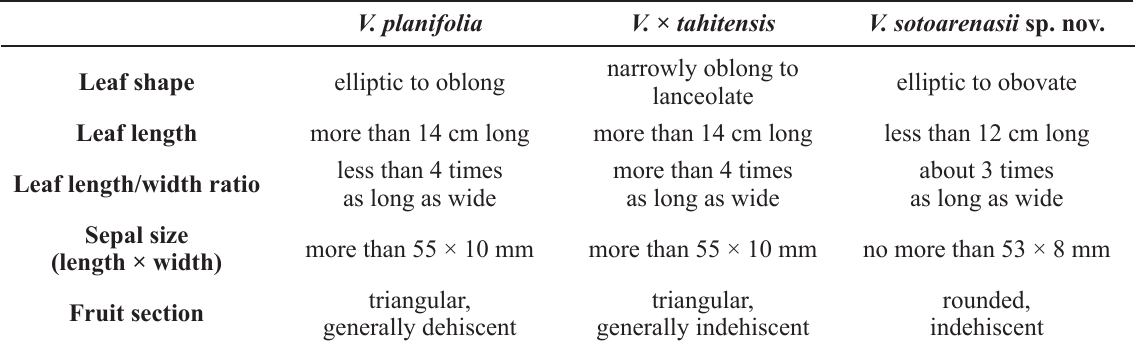
Table 6. Characters differentiating Vanilla sotoarenasii M.Pignal, Azofeifa-Bolaños & Grisoni sp. nov. from related